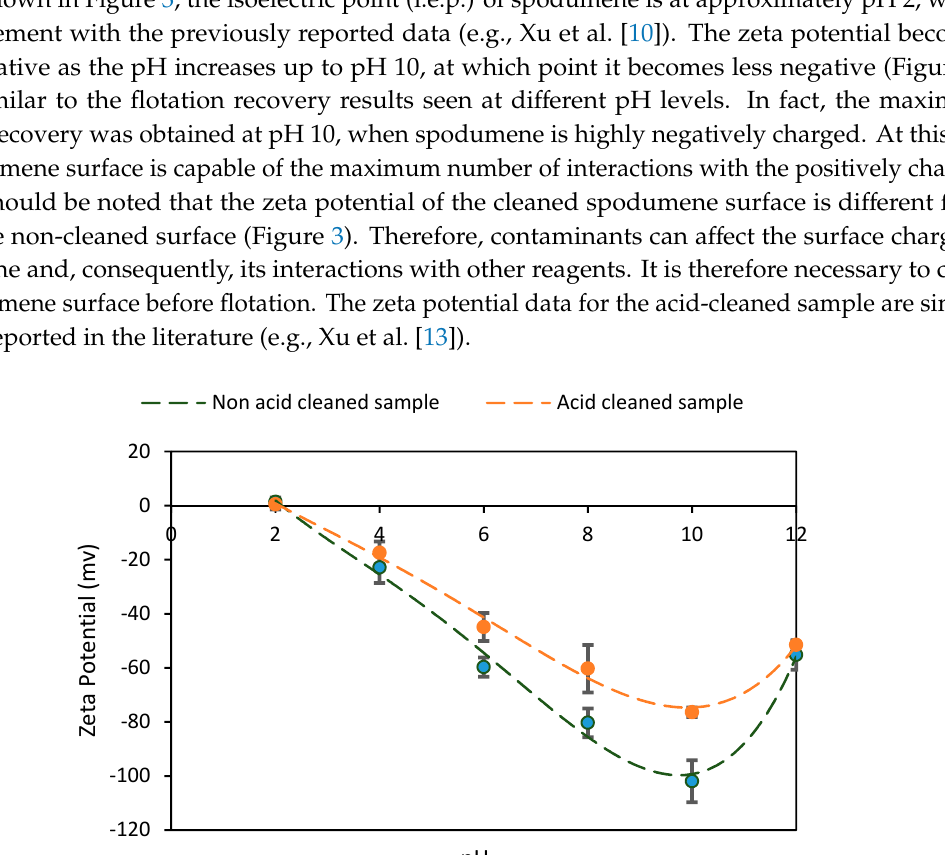
Figure 3. Comparison of the zeta potentials of non-cleaned and cleaned spodumene.